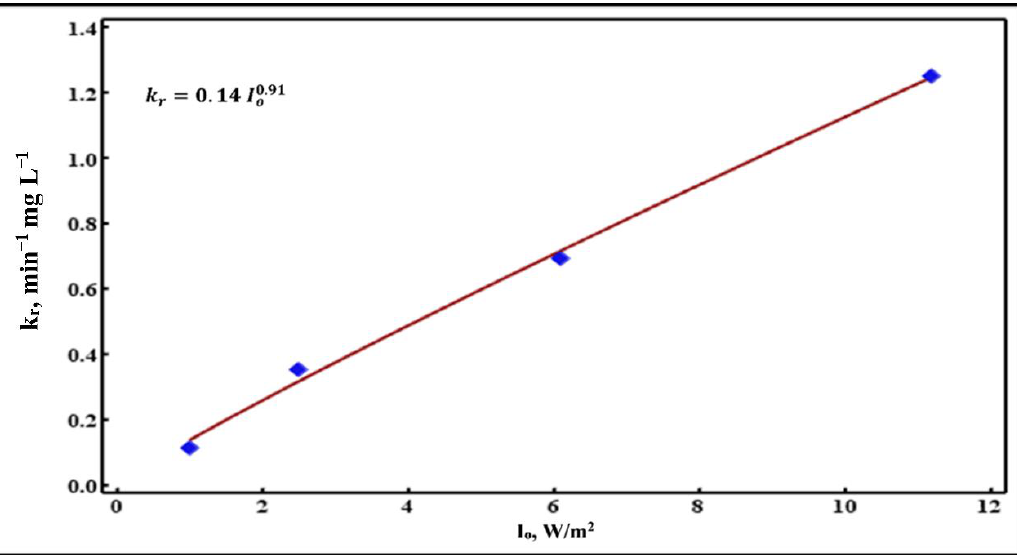
Figure 10. Non-linear regression of k r values vs. different light intensities.